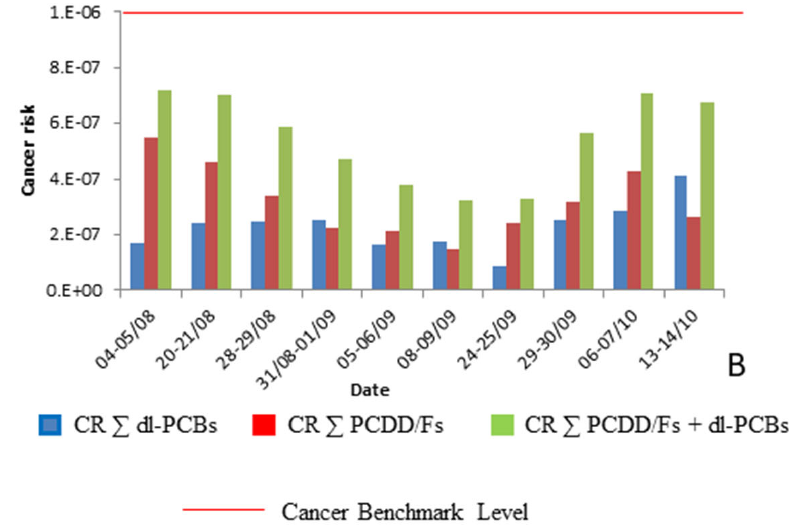
Figure 4. Cancer risk at Chiva ( A ) and Buñol stations ( B ).